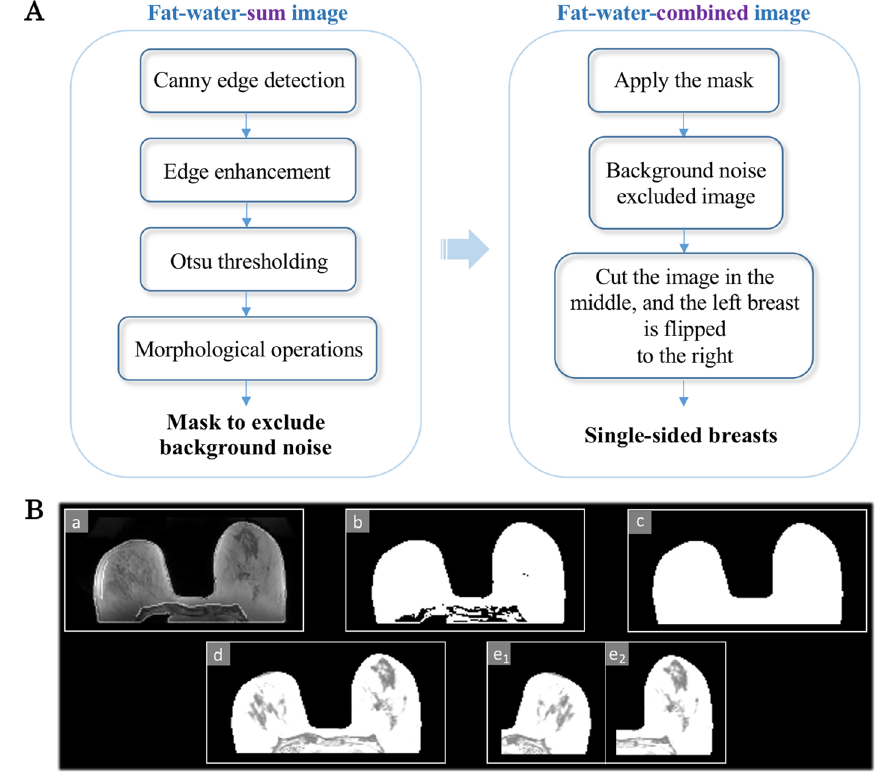
Fig. 1 A . Workflow of the image processing steps for the registration breast segmentation method; B . The step‑by‑step results of the image processing. (a) Edge‑enhanced fat‑water‑sum image after Canny edge detection method, (b) outcome of the Otsu thresholding, (c) mask after morphological operations, (d) body region extracted by applying the mask, and (e 1 ) and (e 2 ) single‑sided breasts generated from D by cutting the breasts in the middle and flipping the left side to the